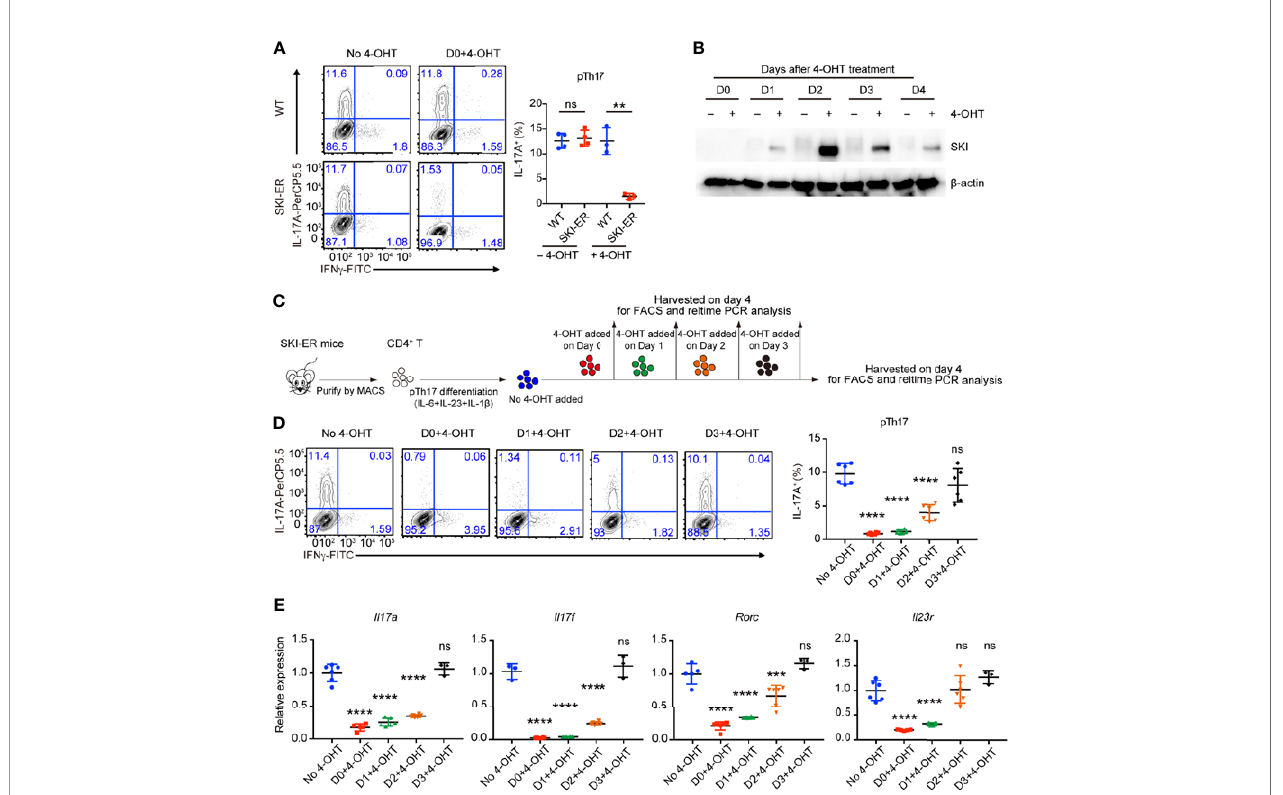
FIGURE 3 | SKI expression suppressed the pathogenic Th17 cell differentiation. (A) Flow-cytometry of IFN g - or IL-17A-producing CD4 + cells from WT and SKI-ER mice cultured under pTh17 (anti-CD3/CD28 plus IL-1 b , IL-6 and IL-23) polarizing conditions with or without 4-hydroxy-tamoxifen for four days. Left, representative plot; right, composite data from three to four mice per group of three independent experiments; means ± s.d., ns, not signi fi cant p > 0.05, **p < 0.01, by two-sided Student ’ s t -test. (B) Immunoblot analysis of SKI and b -actin in SKI-ER CD4 + T cells cultured under pTh17 polarizing conditions added with 4-hydroxytamoxifen (4- OHT) for indicated days as shown. Data were representative of three independent experiments. (C) Schematic diagram of inducing SKI expression at different days during pTh17 differentiation in SKI-ER CD4 + T cells with 4-hydroxytamoxifen (4-OHT). (D) Flow-cytometry of IFN g - or IL-17A-producing CD4 + cells from SKI-ER mice cultured under pTh17 polarizing conditions for four days, with 4-hydroxy-tamoxifen added into cell culture at indicated days. Left, representative plot; right, composite data from 6 mice per group of three independent experiments; means ± s.d., ns, not signi fi cant p > 0.05, ****p < 0.0001, by one-way ANOVA post Holm – Sidak ’ s multiple comparisons test. (E) The mRNA expression of Il17a , Il17f , Rorc and Il23r in pTh17 cells as in (A) . Relative expression levels were measured by quantitative real-time RT-PCR and were normalized to actin expression level using the standard curve method. The data were pooled from three to six mice per group of three independent experiments, n = 3 – 6 mice; means ± s.d., ns, not signi fi cant p > 0.05, ***p < 0.001, ****p < 0.0001, by one-way ANOVA post Holm – Sidak ’ s multiple comparisons